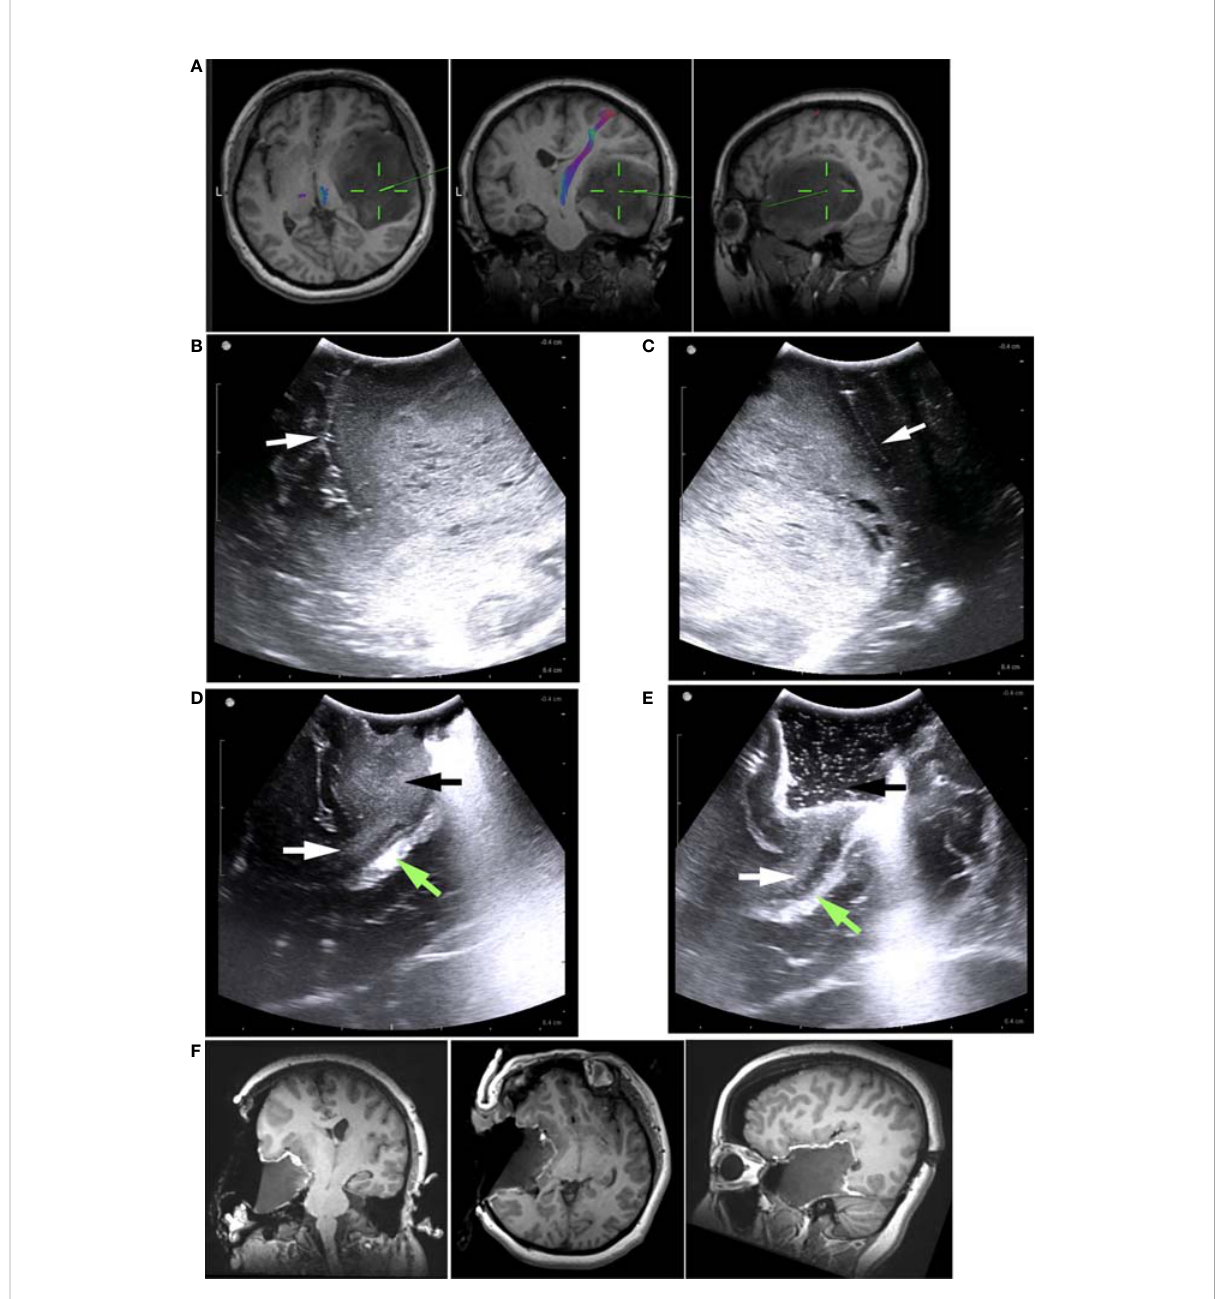
FIGURE 2 Illustrative case 1. (A) The preoperative MRI images revealed a low-grade glioma, predominantly in the right temporal lobe. It was dif fi cult to determine how the tumor is related to the Sylvian fi ssure, insular lobe, or basal ganglia based on MRI images. (B) Pre-resection iUS image showing the tumor ’ s hyperechoic signal. Sylvian fi ssure (white arrow) and insular cortex were clearly visible on the iUS images. The insular cortex was not in fi ltrated by the tumor. The Sylvian fi ssure marked the upper border of tumor (C) In another pre-resection iUS image, the posterior margin was marked by a sulcus (white arrow). (D) Following partial removal of the tumor, the temporal stem (white arrows) was visible on the iUS image. There was no sign that the tumor (black arrow) had grown into basal ganglia through the temporal stem. The Green arrow indicated the ventricle. (E) Intermediated iUS revealed that the tumor was further removed along the temporal stem (white arrow). The Green arrow indicated the ventricle. (F) In iMRI images, the tumor was successfully removed along the Sylvian fi ssure and temporal stem. The insular cortex and basal ganglia were